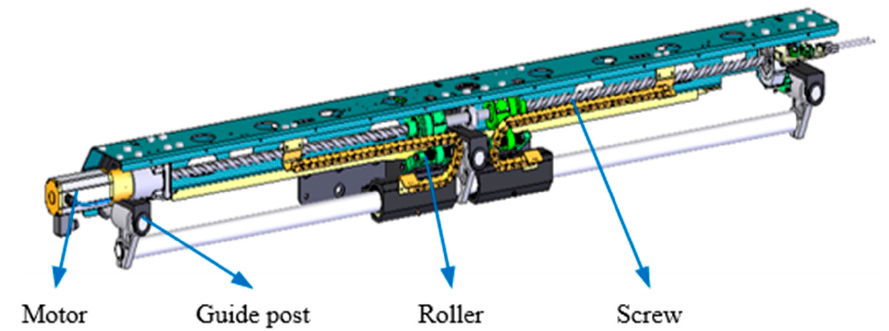
Figure 7. Structural drawing of sliding door transmission system.